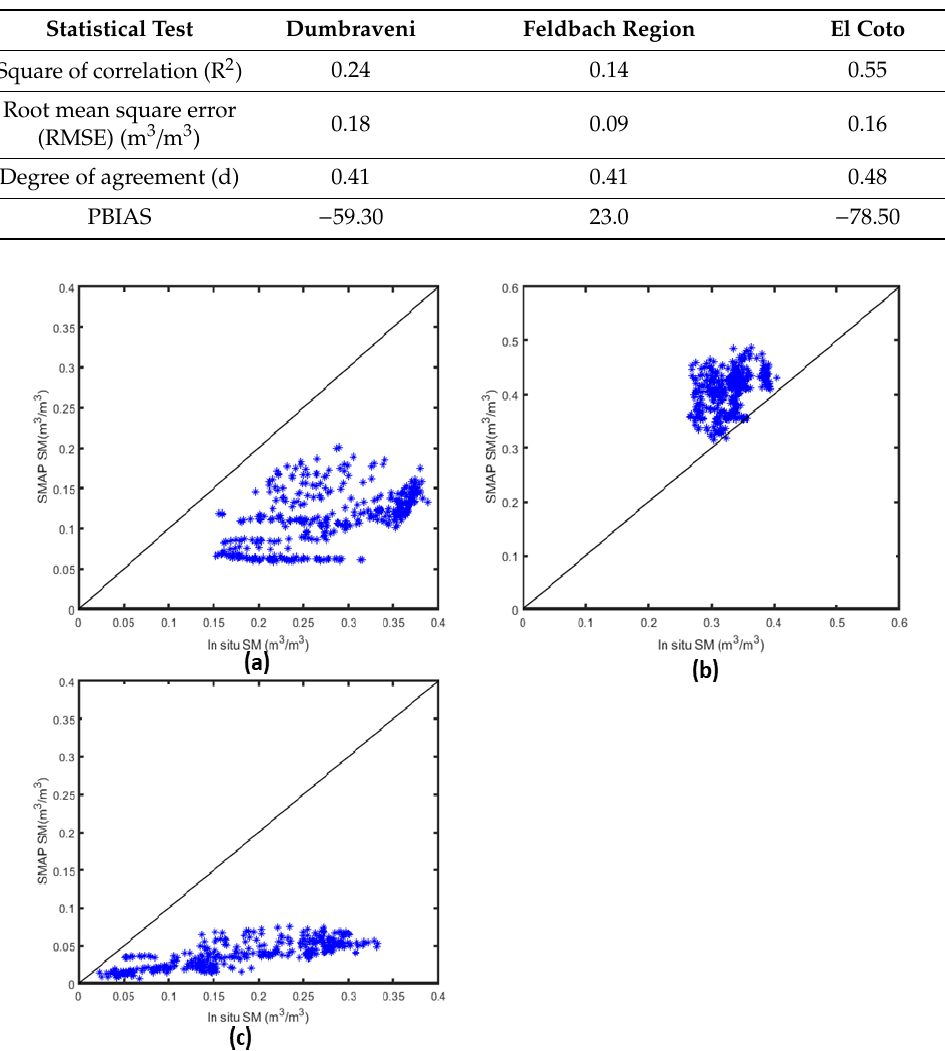
Figure 5. Comparisons between the SMAP SM and in situ SM for ( a ) Dumbraveni, Romania ( b ) Feldbach, Austria and ( c ) El Coto, Spain, Europe.